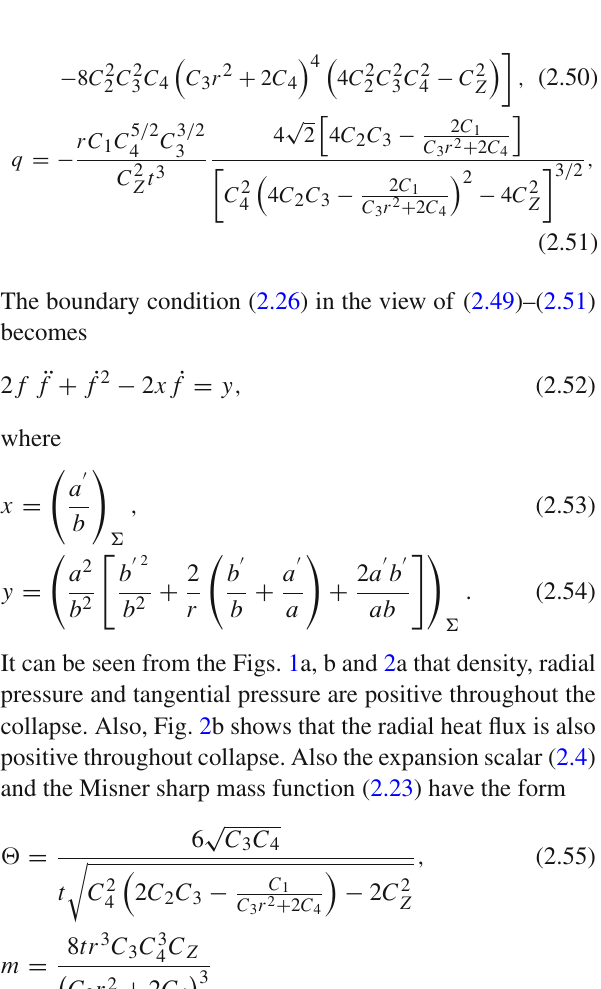
Fig. 1 a Plot of the density ρ , Eq. (2.48), with respect to r at center r = 0 and at the surface of the star at r = 1. This plot shows that the density is positive as the collapse starts at t = − 100 and is maximum at the end state of the collapse at t = 0. b Plot of the radial pressure